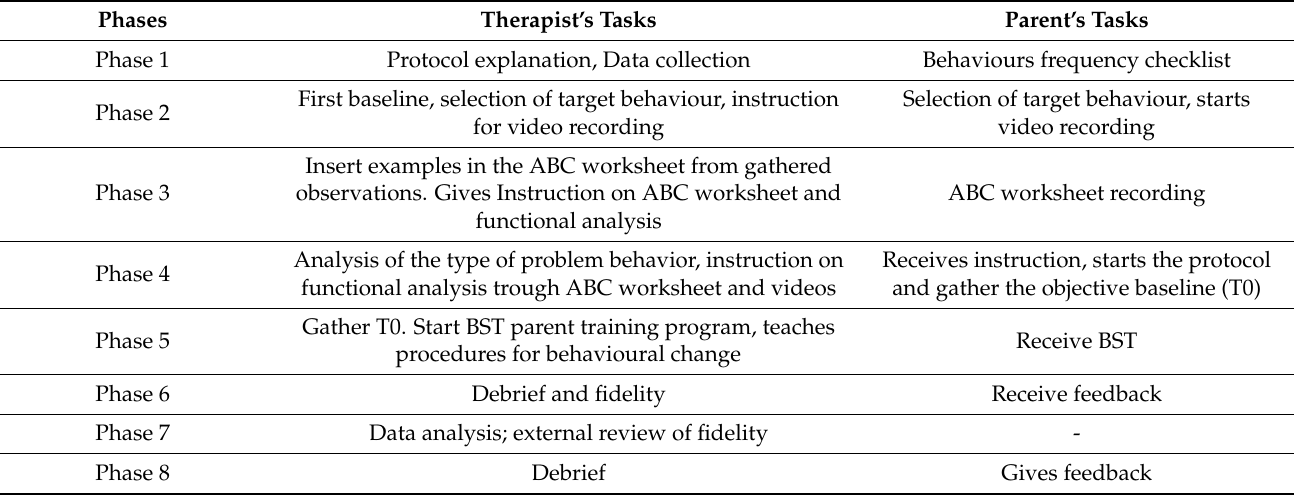
Table 1. Protocol